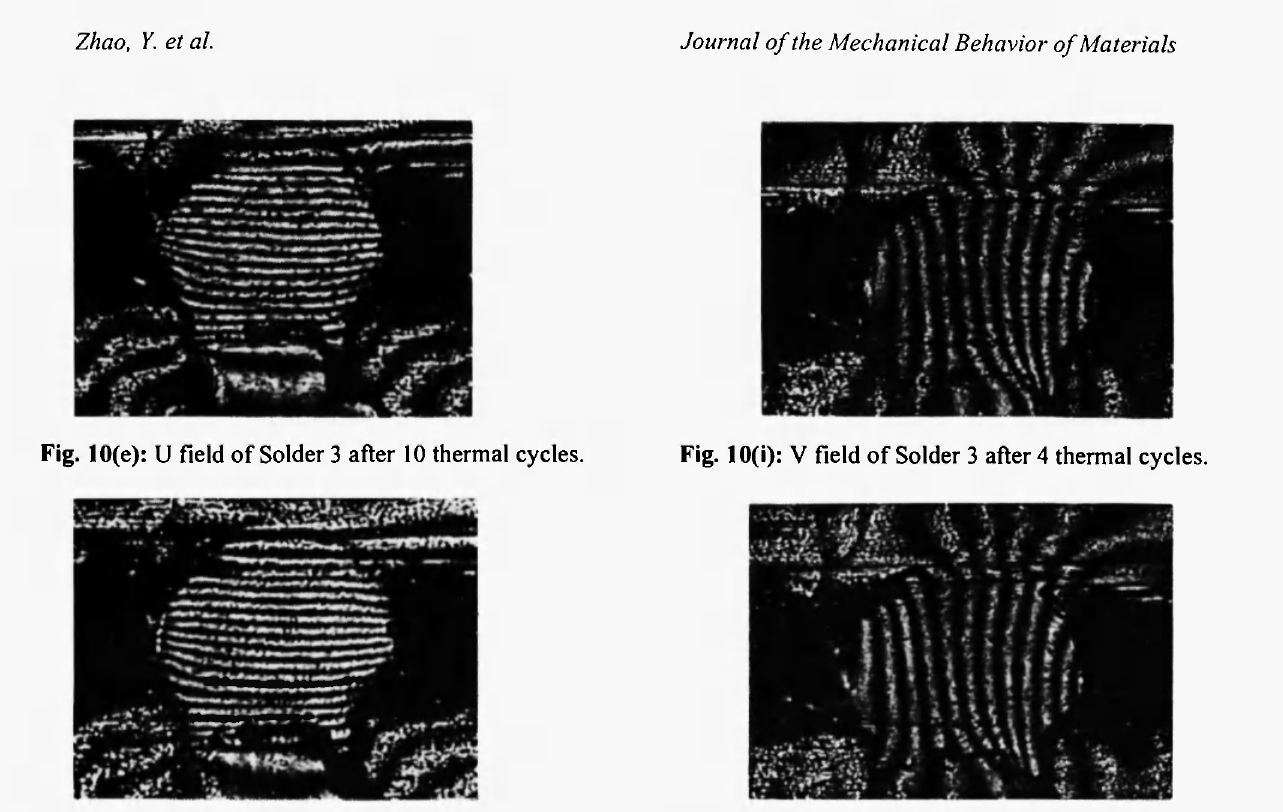
Fig. 10(f ):U field of Solder 3 after 14 thermal cycles.